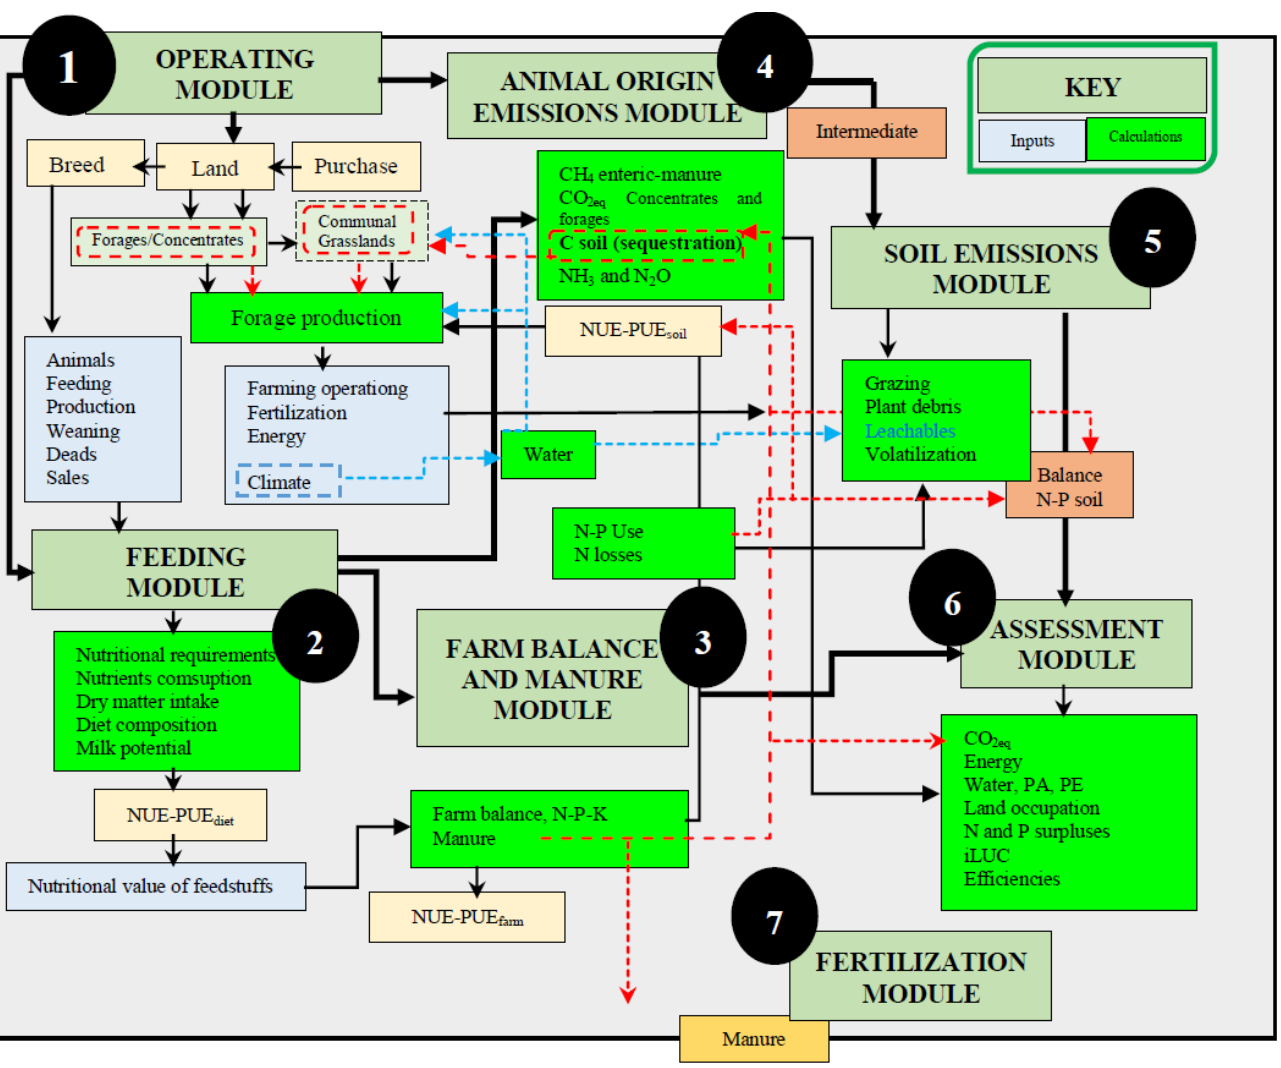
Figure 1. The ManleCO 2 simulation model. Table 1. Characteristics of the herds used in the simulation.